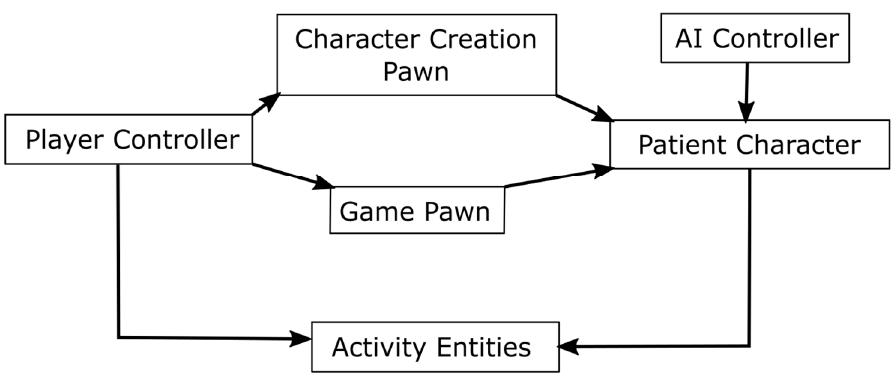
Figure 7. The game’s main actors and the relationships among them.